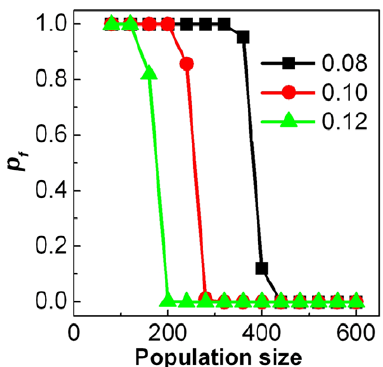
Figure 3. The effect of energy lost per escape on the evolution of fearfulness and boldness where e =0.08, 0.10 and